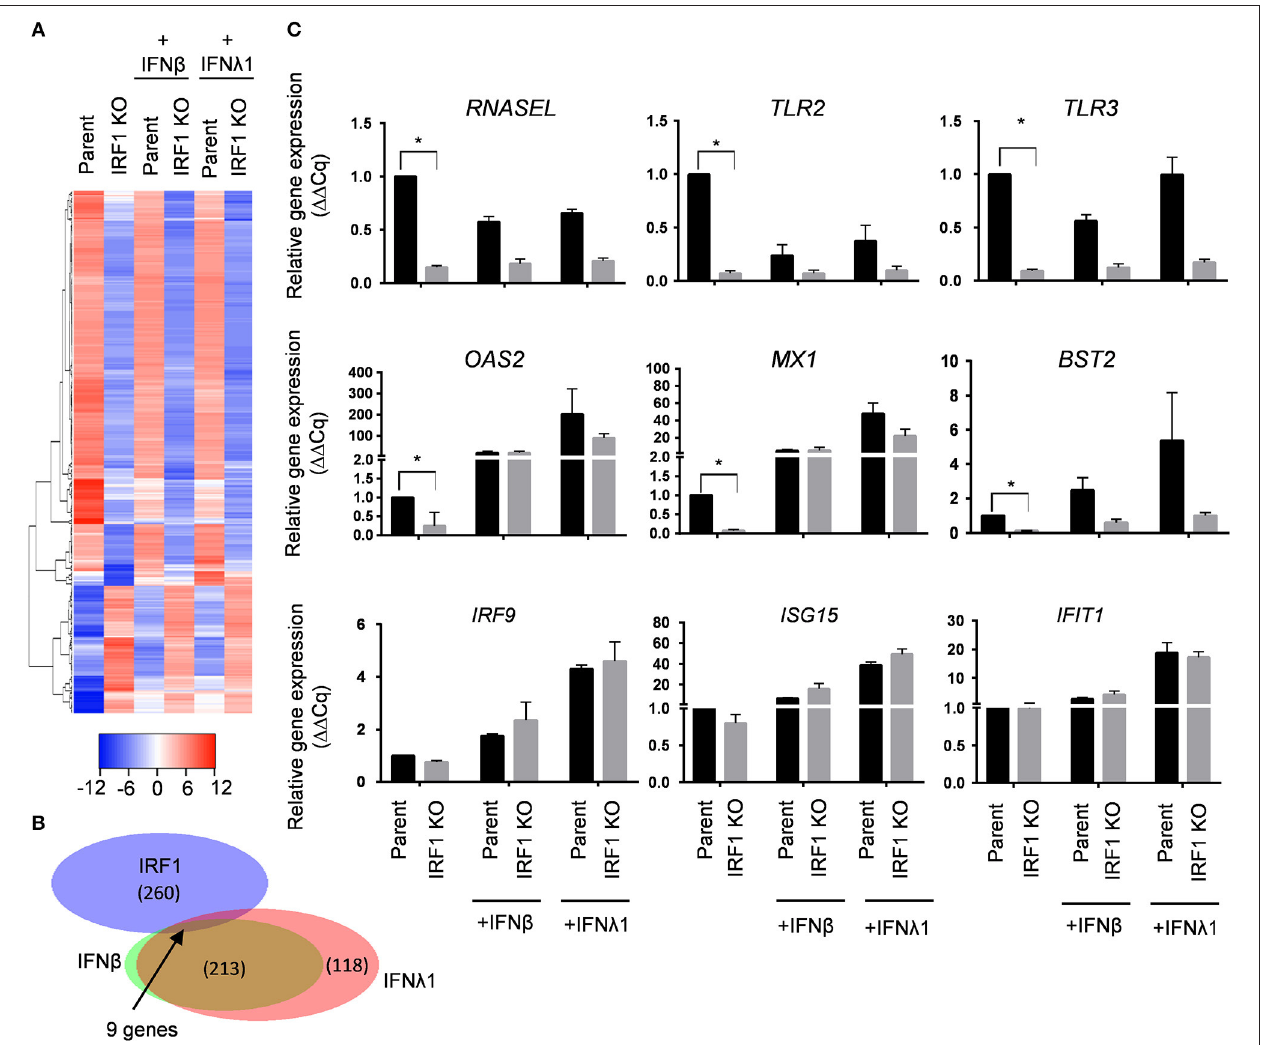
FIGURE 5 | IRF1 regulates basal expression of a subset of ISG in BEAS-2B cells. (A–C) Parent and IRF1 KO cells were either treated with IFN β (0.2ng/ml) or IFN λ 1 (5ng/ml) for 24h and gene expression was analyzed by RNA-seq. Heat map (A) and Venn diagram (B) for IRF1 dependent- and IFN inducible genes are shown. (C) Validation of IRF1 dependent, non-ISGs (top row), IRF1 dependent ISGs (middle row) and IRF1-independent ISGs (bottom row) expression by RT-qPCR using comparative C q method (2 − 11 Cq ). Data represent mean ± SEM from three independent experiments. *Statistically significant.